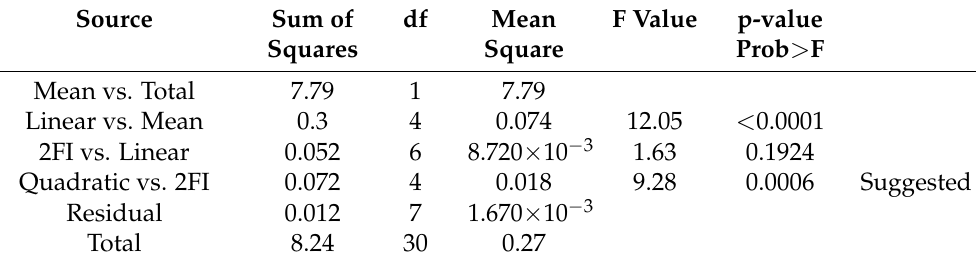
Table 12. Sequential model sum of squares [GRG].